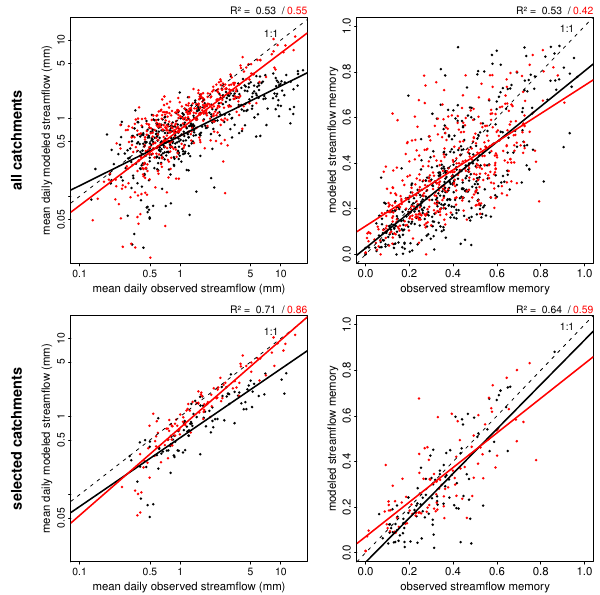
Figure 2: The left plots show modeled versus observed mean daily streamflows for June (in black) and October (in red). Note the logarithmic scale of both axes. The thick straight lines are fitted with least-squared regression, R 2 values shown on top are a result of this. The right plots show the same, only for mean monthly streamflow memory ρ ( Q n ,Q n +15 days ) . The upper row shows results for all 441 catchments, the lower row only contains the selected catchments.